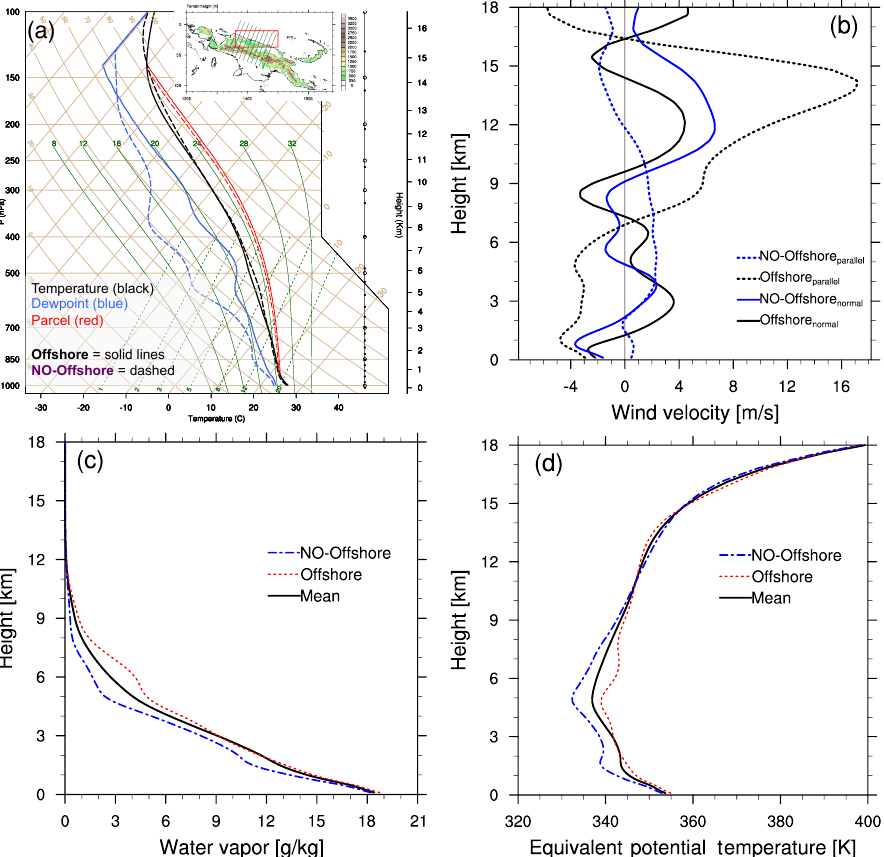
Figure 7. Mean profiles averaged within the region denoted by the red box in the inset. (a) Simulated temperature (black), dew point (blue) and parcel temperature (red) averaged for offshore (solid) and no-offshore (dashed) days. (b) Vector wind in the direction normal (solid) and parallel (dashed) to the coast on offshore (black) and no-offshore (blue) days. Positive values of normal velocity flow towards the north-north- east and parallel velocity flow towards the west-north-west. (c) Water vapour mixing ratio (gkg − 1 ) and (d) equivalent potential temperature (K) for offshore and no-offshore days compared to the February